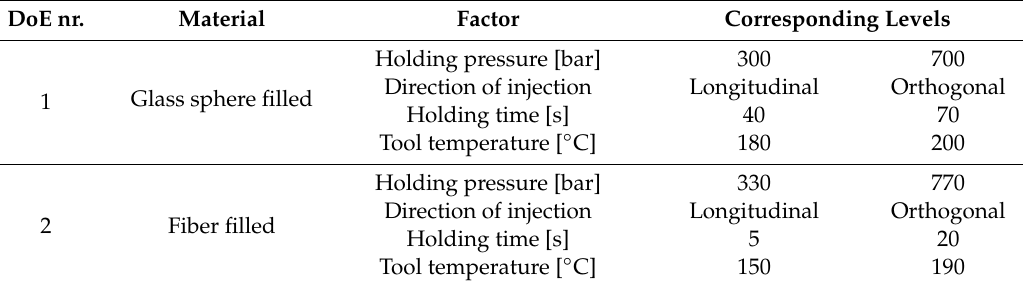
Figure 4. ( a ) measurement side of the cavity. Bumps for dimensional analysis were milled using precision machining. ( b ): mirror side of the cavity. The reflective surface was milled in NiP coating using ultra-precision machining employing diamond mill bits.